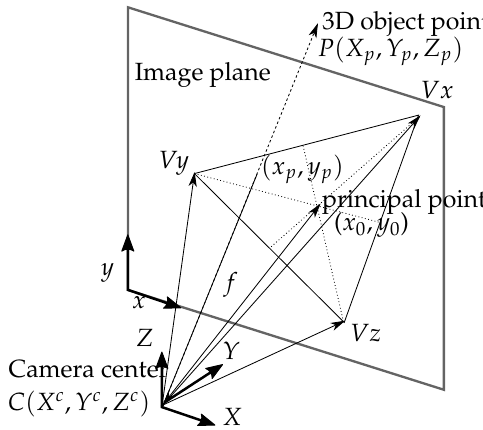
Figure 3. An illustration of the camera (exposure station), 3D point (object), and its photo image, which all lie on a straight